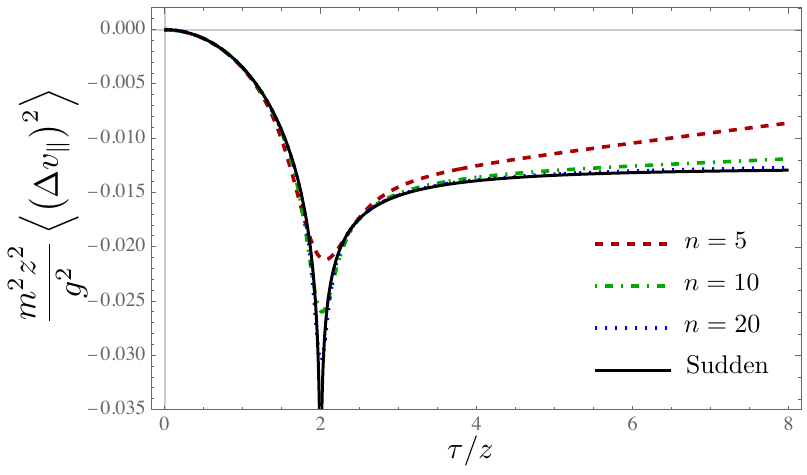
Figure 3 . Dispersion of the parallel component of the particle velocity as function of (cid:28) for the sudden switching regime (solid curve) and for some values of n in the case of a smooth switching.